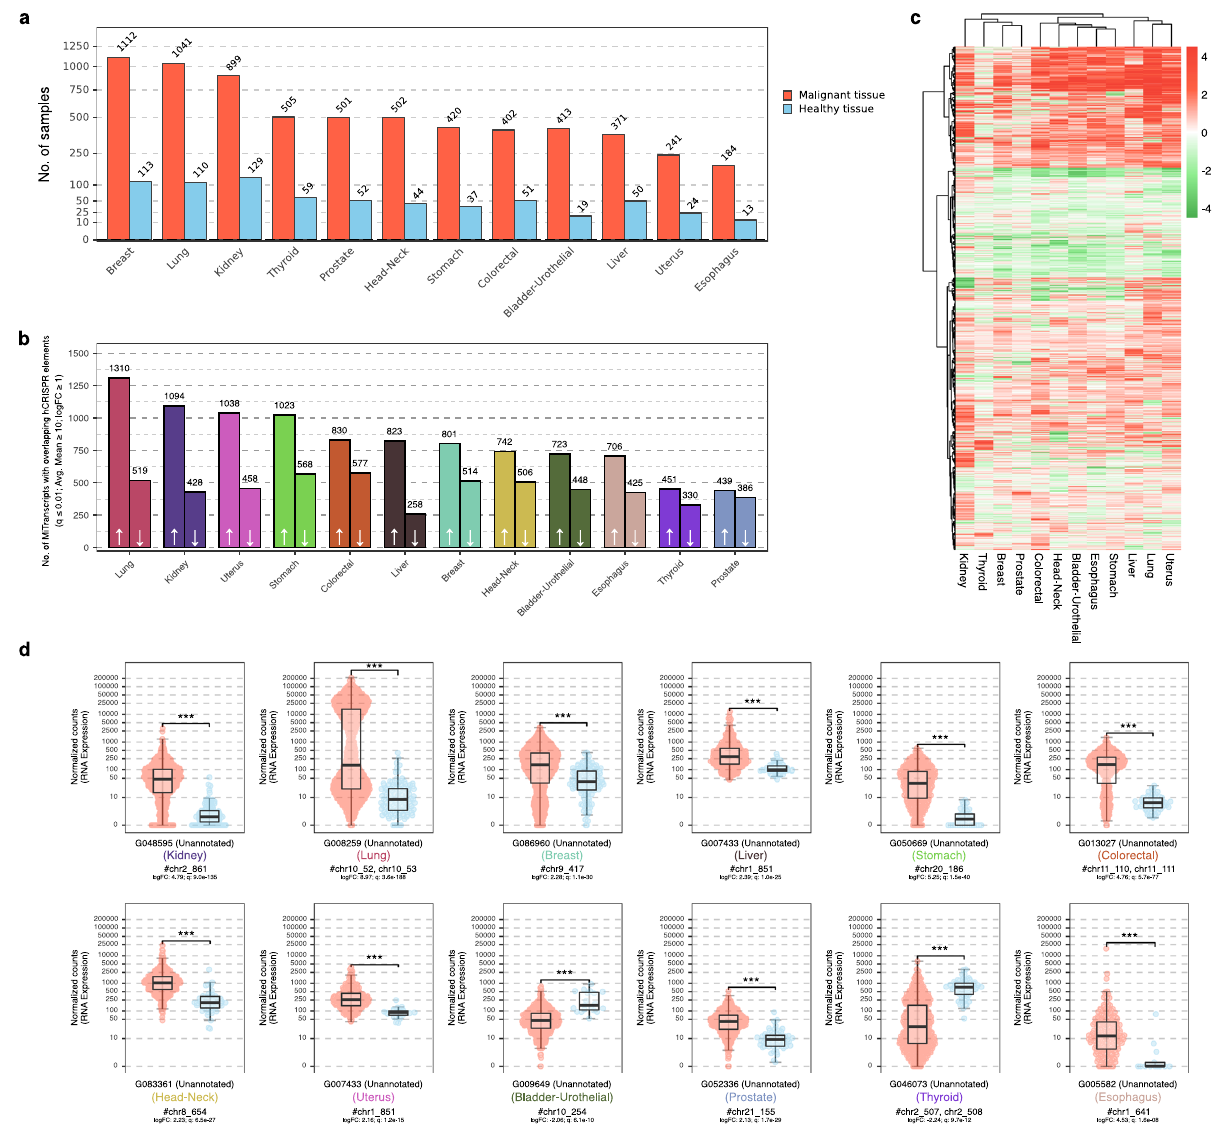
Fig. 6 Cancer-speci fi c expression of MiTranscripts overlapping hCRISPR within the MiTranscriptome cohort. a Overview of tissue distribution per tumor subtype within the MiTranscriptome dataset which consisted of at least 10 healthy and 10 malignant samples. b Number of differential MiTranscriptome transcripts between healthy and malignant tissue per malignant tissue (|log 2 fold-change| ≥ 1, an average read-count of at least 10 over all samples in the respective tissue and q ≤ 0.01). Number of transcripts are shown per direction (up (left) / and downregulated (right)) as separate bars. c Unsupervised clustering (Euclidean clustering; Ward.D2) of all distinct differential Mitranscriptome transcripts ( n = 4622) using their normalized expression (VST). Negative Z-scores are highlighted in green whilst positive Z-scores are highlighted in red. d Boxplots representing the normalized expression (VST-transformed read-count) of a representative unannotated Mitranscriptome transcript overlapping with a single hCRISPR per distinct malignant tissue; median, Q1 and Q3 are highlighted with a bold black line and error bars, respectively. Normalized expression (VST-transformed read- count; y -axis) is shown in log 10